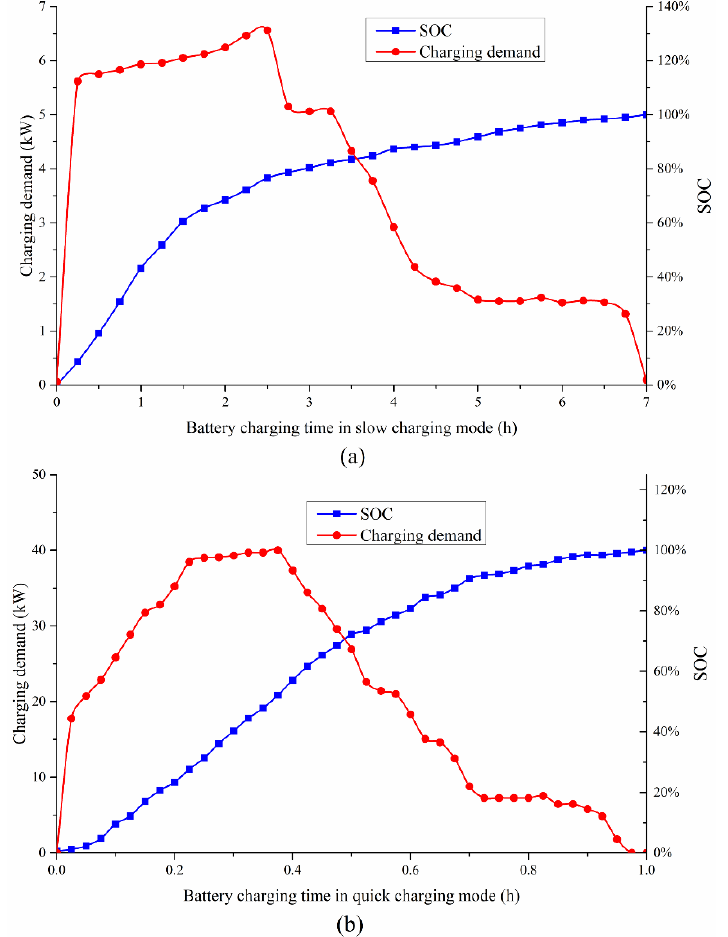
Figure 5. Charging profiles of the GM EV1 battery (lead-acid) ( a ) in slow charging mode and ( b ) in quick charging